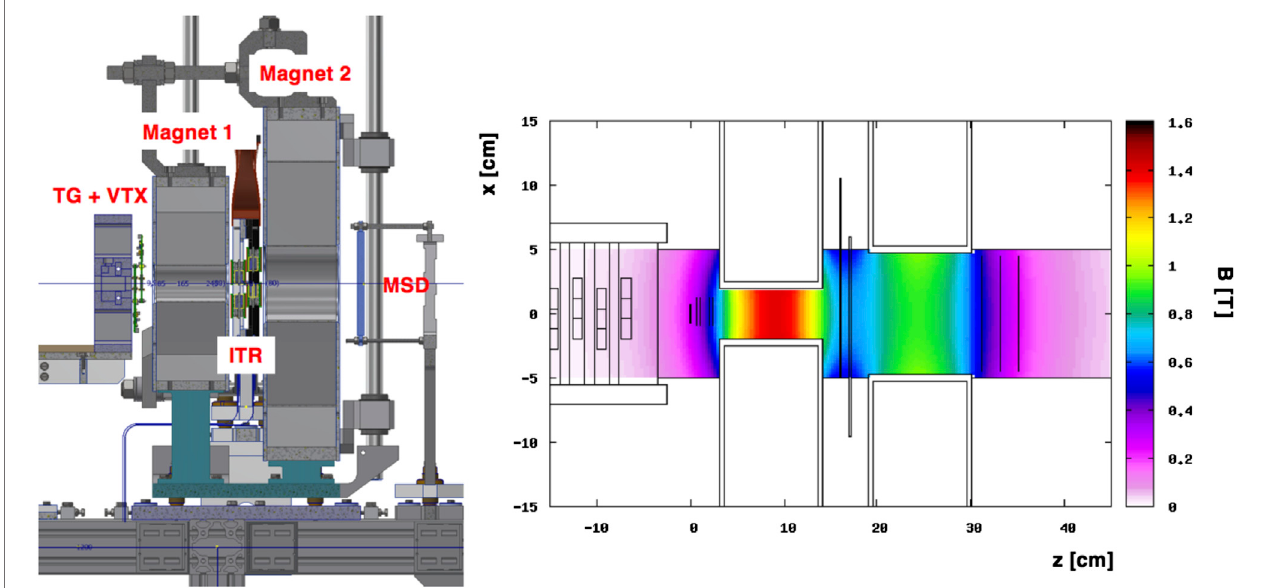
FIGURE4|(Left) Technicaldesignoftheinteractionandtrackingregions:theverticalaxisisthe y axis,whilethehorizontalaxisisthe z axis.Thebeamcomingfrom theleft,alongthe z -axis,crosssequentiallythetarget(TG),thevertexdetector(VTX),movesintothemagnetsregionandcrossestheInnerTracker(ITR)and,immediately after the second magnet, passes through the Micro Strip Detetor (MSD). (Right) Computed magnetic fi eld map produced by the FOOT magnets in Halbach con fi guration. The magnetic fi eld intensity B , shown in the palette, is referred to its y -axis component.